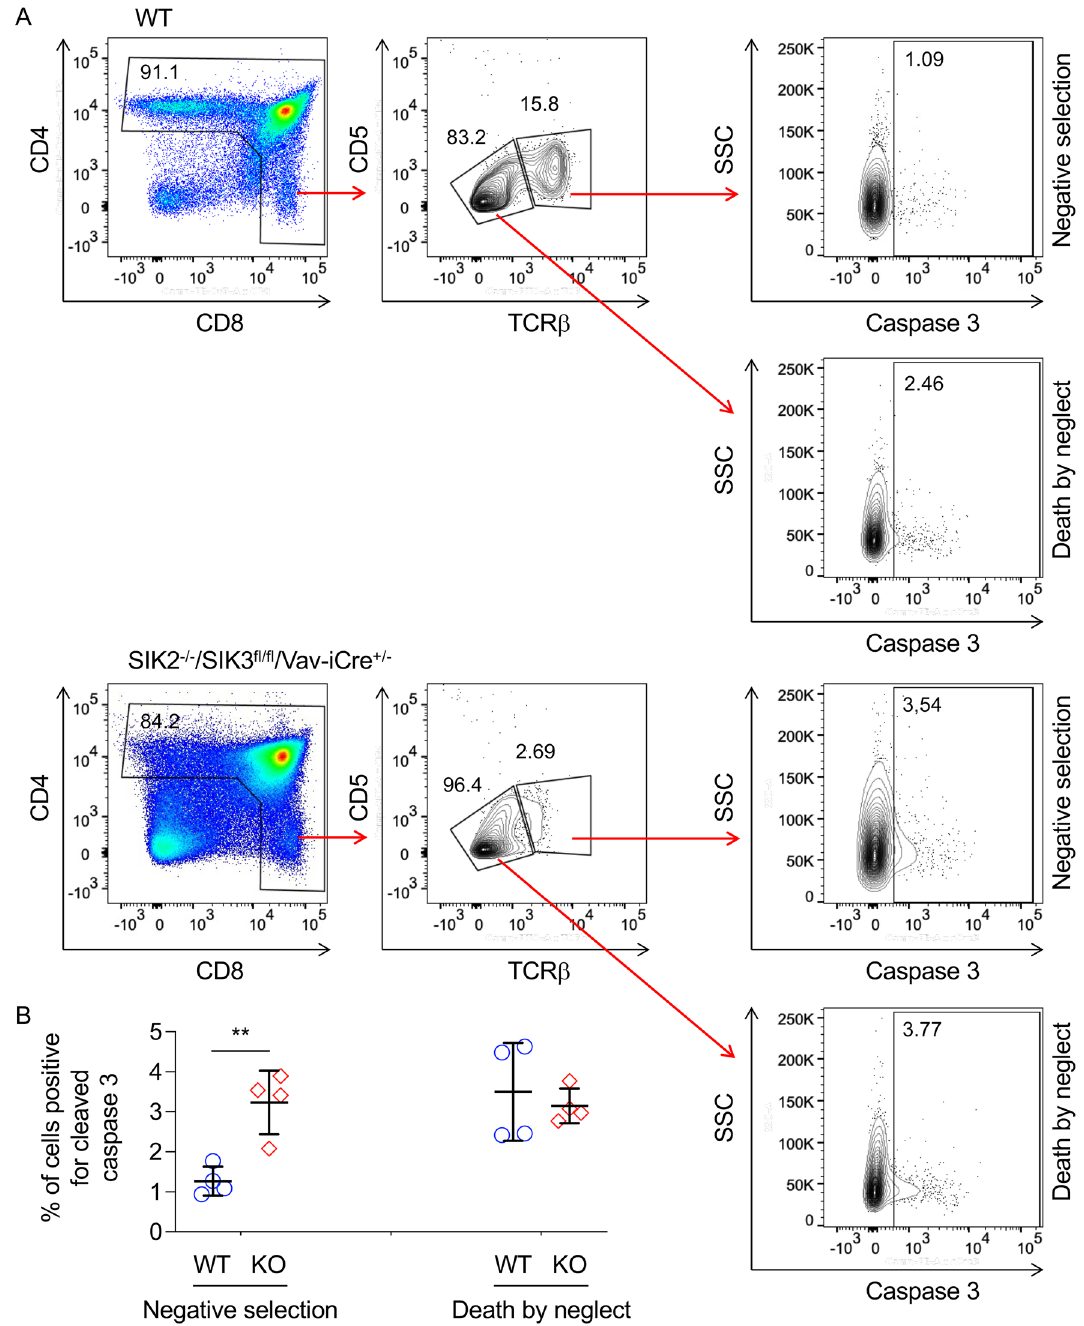
Figure 7. Loss of SIK2 and SIK3 resulted in increased apoptosis in cells undergoing negative selection. Thymi were isolated from wild type and SIK2 −/− /SIK3 fl/fl /Vav-iCre +/− (KO) mice and stained for CD4, CD8, TCRβ, CD5 and cleaved caspase 3. Gating on expression of CD4 and/or CD8 was used to identify cells at the DP or SP stage of development. Cells were then gated based on TCRβ and CD5 to identify activated cells that may be undergoing negative selection or DP cells that were TCRβ low and may be undergoing positive selection. The percentage of cells positive for cleaved caspase 3 was then determined in these gates. Representative gating is shown in ( A ), and quantification of 4 mice per genotype in ( B ). Data was analysed by RM two way ANOVA and Sidak’s post hoc testing with ** indicating a p value <